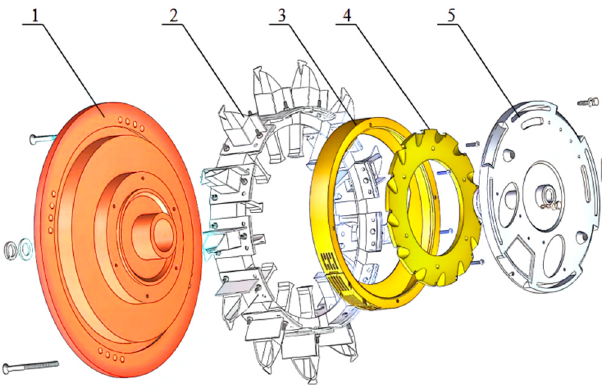
Figure 1. Structural diagram of double-bin rotary disc type cotton vertical disc hole seeding and metering device: (1) moving plate, (2) seed hopper assembly, (3) seed Spacer, (4) seed tray, and (5) core plate.